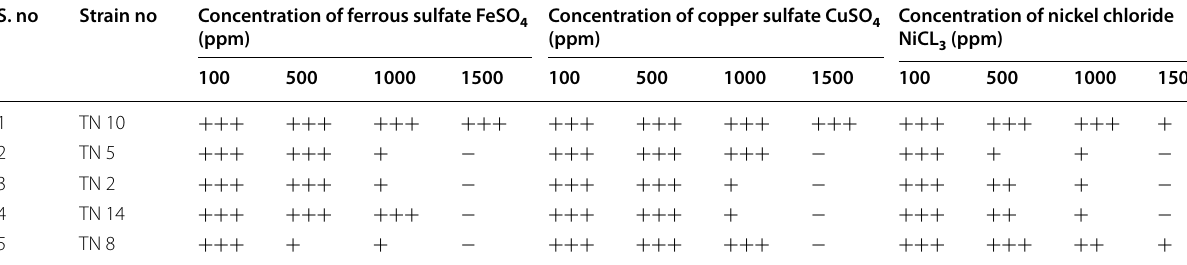
, excellent growth; +++